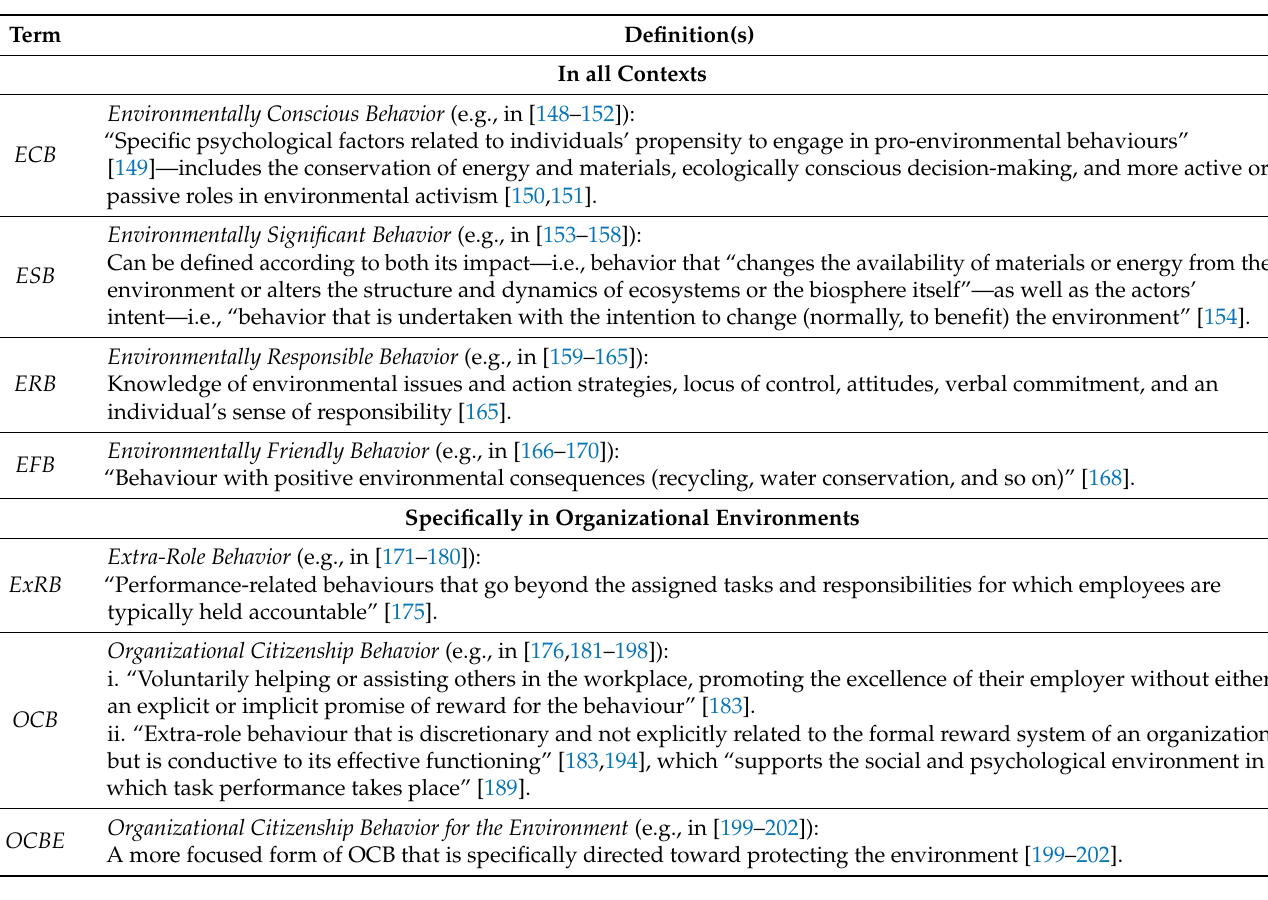
Table 7. “Soft” interventions—effective strategies for organizational energy efficiency and conserva- tion with minimal or no changes on the physical characteristics of the